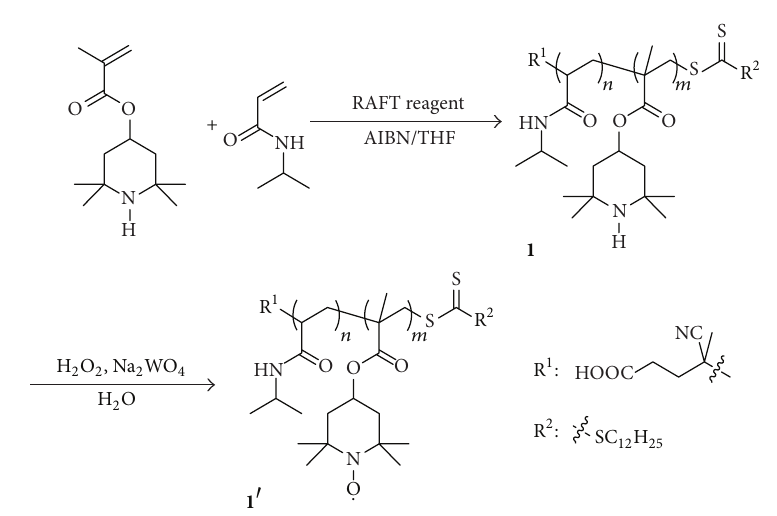
Scheme 1: Synthesis of poly(TEMPOMA- ran -NIPAAm).